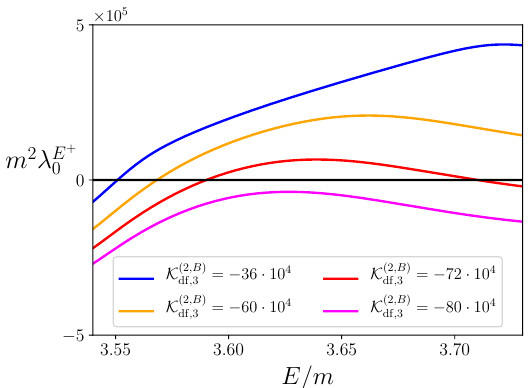
Figure 9. Smallest eigenvalue in magnitude of F (cid:0) 1 two di(cid:11)erent values of mL . The parameters are ma 0 = unphysical solutions as well as a double pole at the free energy (to be discussed in section 4.4.3) are indicated.